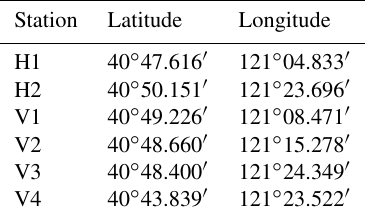
Table 1. The coordinates of the monitoring